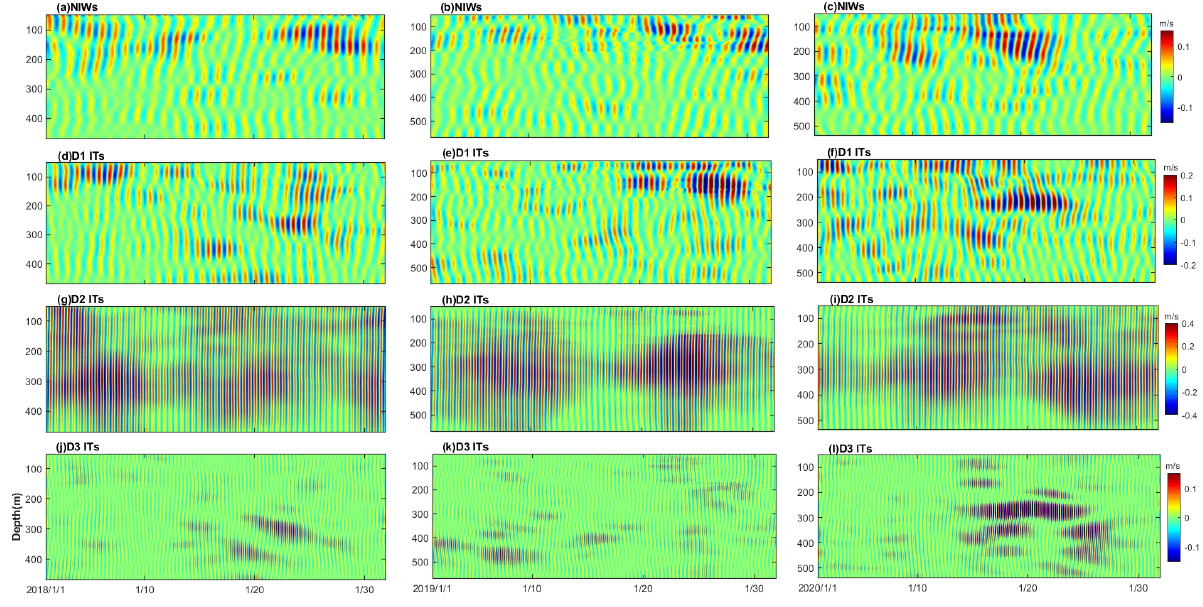
Figure 15. Time–depth plots of the zonal currents of NIWs ( a – c ) and D1 ( d – f ), D2 ( g – i ), and D3 ( j – l ) ITs in January 2018 ( a , d , g , j ), 2019 ( b , e , h , k ), and 2020 ( c , f , i , l ) at the